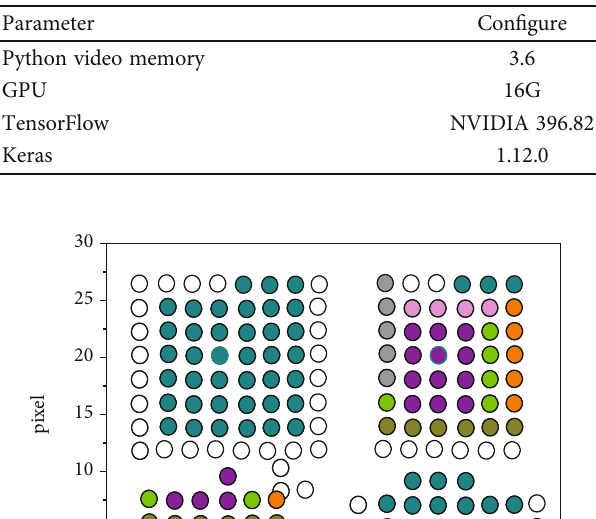
Table 1: Con fi guration of the experimental platform.